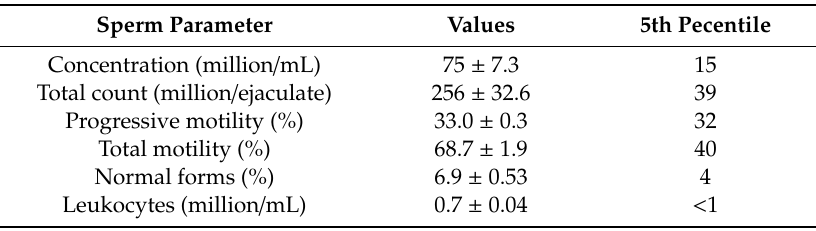
Table 1. Sperm parameters (mean ± SEM) of the 30 healthy normozoospermic men enrolled in this